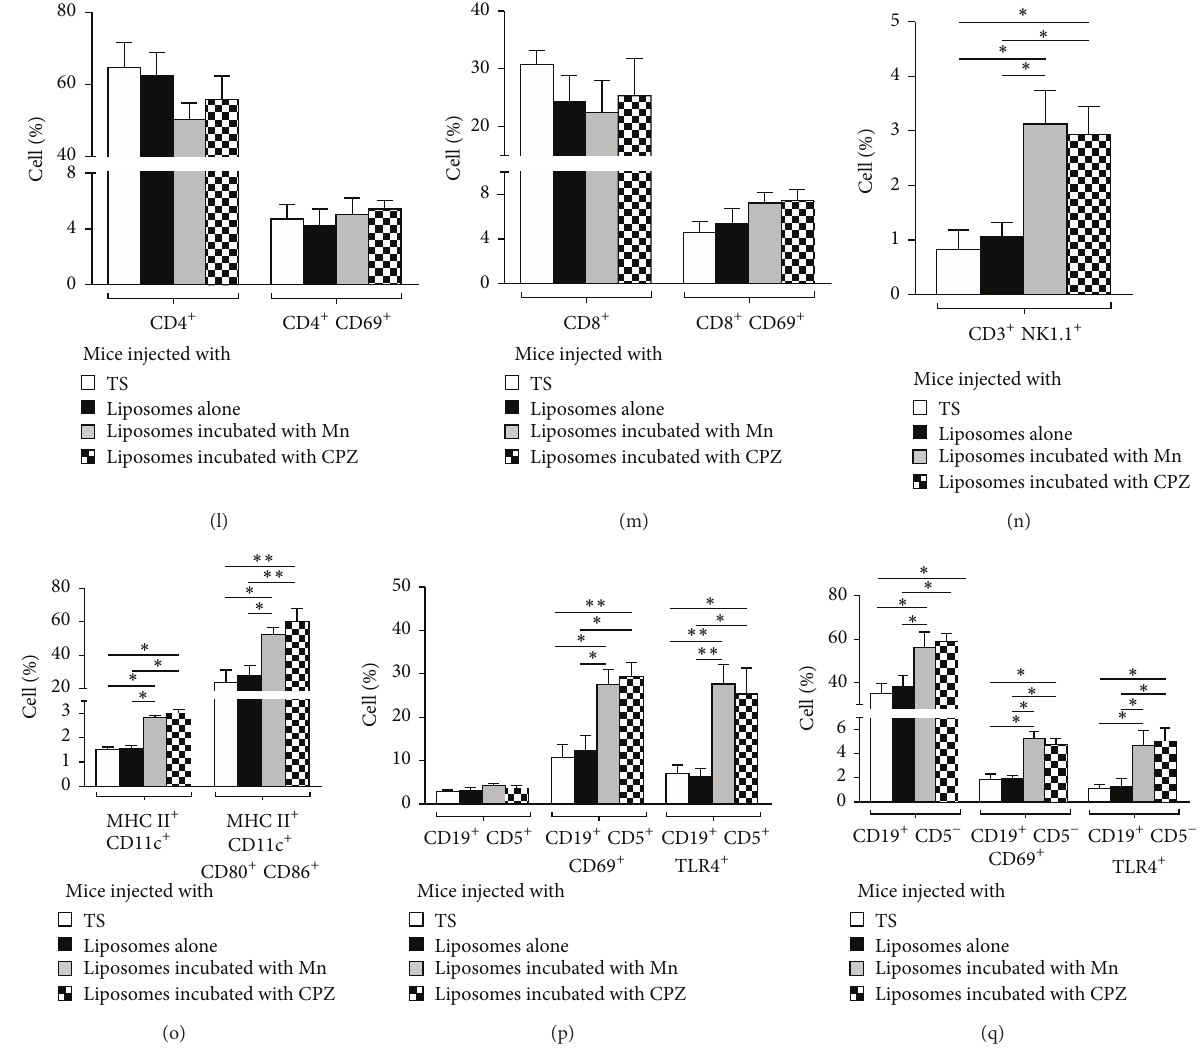
Figure 6: Dendritic, B1, and B2 cells are activated in mice with an autoimmune disease resembling human lupus. To analyze the percentage and activation of immune cells, cell suspensions from the spleens of mice injected with TS buffer, liposomes alone, or liposomes incubated with Mn or CPZ were labeled with antibodies and analyzed by flow cytometry. Gating strategy for the identification of activated CD4 (CD3 + , CD4 + , CD8 − , and CD69 + ) (a–c) and CD8 (CD3 + , CD4 − , CD8 + , and CD69 + ) (a, b, and d) T cells; NKT cells (CD3 + , NK1.1 + ) (e, f); activated dendritic cells (MHCII + , CD11c ++ , CD80 + , and CD86 + ) (g, h); activated B1 (CD19 + , CD5 + , and CD69 + ) and B2 (CD19 + , CD5 − , and CD69 + ) cells; and expression of TLR-4 (i–k). Percentage of total NKT (n); total and activated CD4 (l) and CD8 (m) T cells, dendritic cells (o), and B1 (p) and B2 (q) cells. The expression of TLR-4 was evaluated on B1 (p) and B2 (q) cells. Kruskal-Wallis test with Dunn’s post-test was used for statistical analysis; significance was set at 𝑝 < 0.05 . Asterisks represent statistically significant differences between the indicated groups ( ∗ 𝑝 < 0.05 , ∗∗ 𝑝 < 0.01